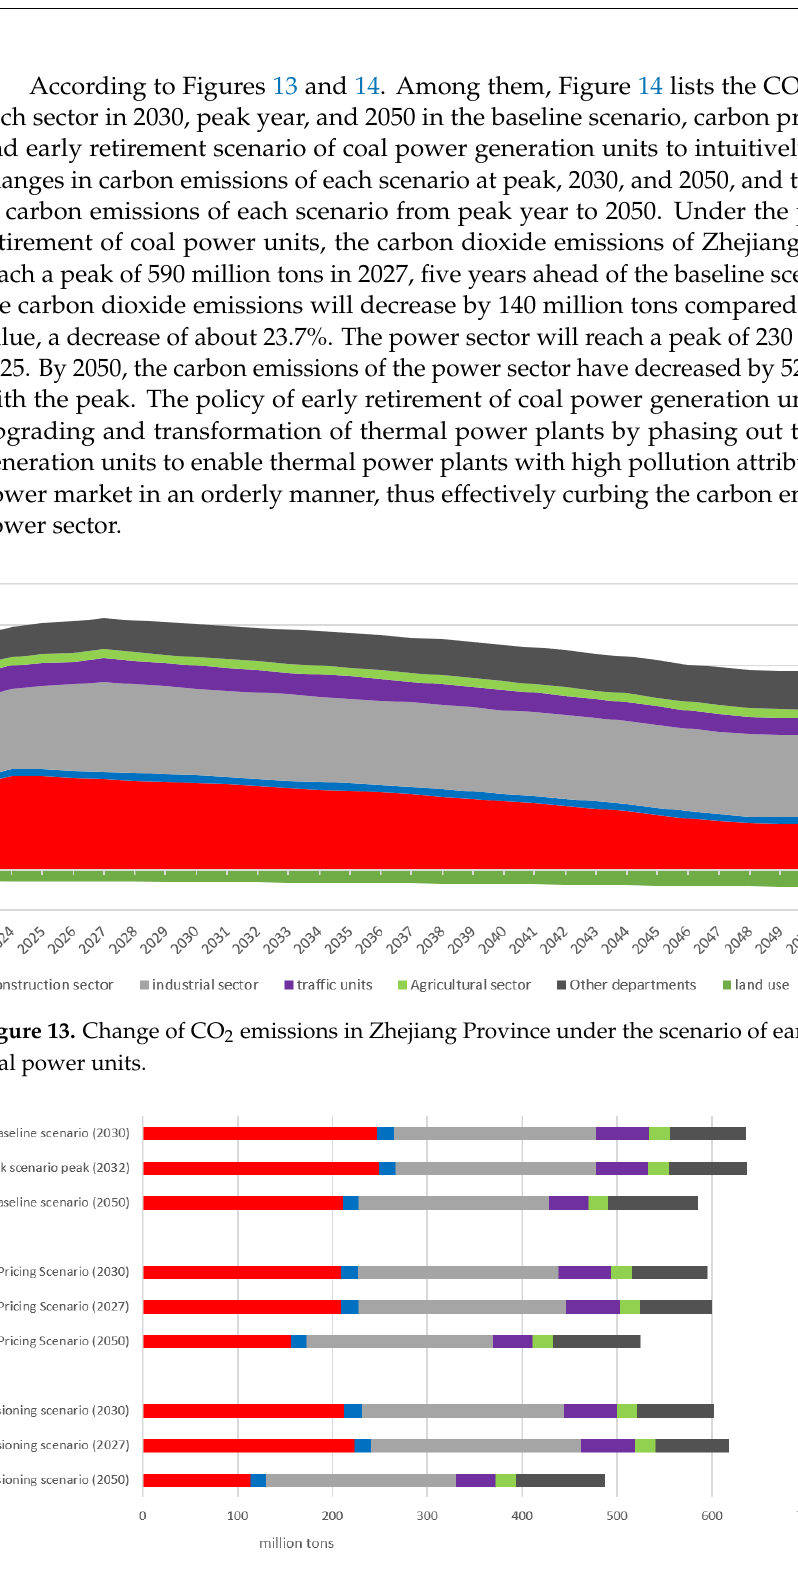
Figure 15. Power generation change in Zhejiang Province under the scenario of early retirement of coal power units. As shown in Figures 16 and 17, the power sector in Inner Mongolia will achieve a carbon peak in 2026. Subsequently, the carbon dioxide emissions showed a significant downward trend. Compared with the peak, the carbon dioxide emissions in 2050 de- creased by about 540 million tons, a decline of 66.7%. The policy effect was obvious. On the whole, the emission of carbon dioxide in Inner Mongolia will reach a peak of 3.9 billion tons in 2033. In 2050, the carbon emissions will be 3.72 billion tons, a decrease of about 4.6% compared with the peak carbon emissions. Compared with the baseline scenario, the policy of early retirement of coal power generation units did not make the carbon dioxide emissions in Inner Mongolia rebound, indicating the effectiveness of the policy. According to Figure 18, thermal power generation in Inner Mongolia will reach a peak of 743.8 TWh in 2025, and then continue to decline. Thermal power generation ac- counted for 9.2% of the total power generation, down from 60.4% at the peak of thermal power generation. During this period, photovoltaic and wind power continued to expand, accounting for 46.5% and 27.2%, respectively, in 2050, becoming the main power genera- tion path in Inner Mongolia. As the policy of early retirement of coal power generation units is carried out gradually every year, no additional cost is imposed like the carbon pricing policy, which has less impact on the local power market. Moreover, after the policy is released, the government and power generation enterprises will have an expectation for the future and adjust the power generation structure accordingly. Therefore, affected